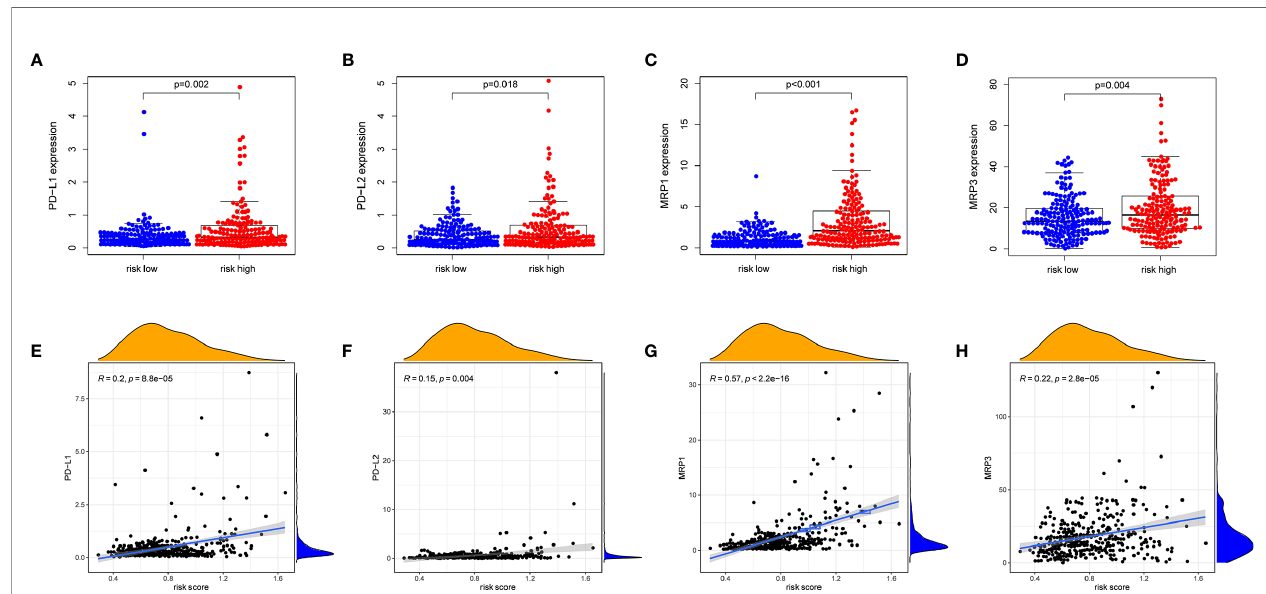
FIGURE 7 | The comparison of the expression levels of PD-L1, PD-L2, MRP1 and MRP3 between different risk groups and correlation analysis between risk score and the expression levels of PD-L1, PD-L2, MRP1 and MRP3. (A, E) PD-L1. (B, F) PD-L2. (C, G) MRP1. (D, H)